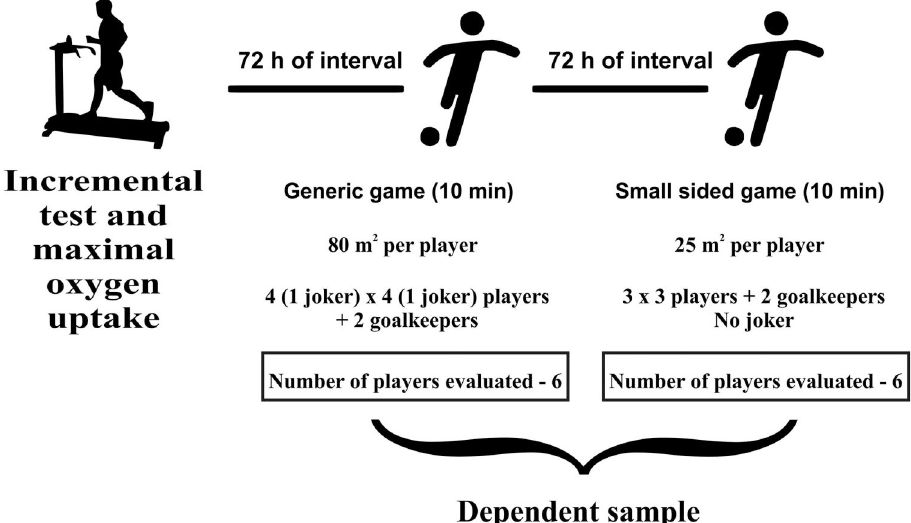
Figure 1 - Experimental